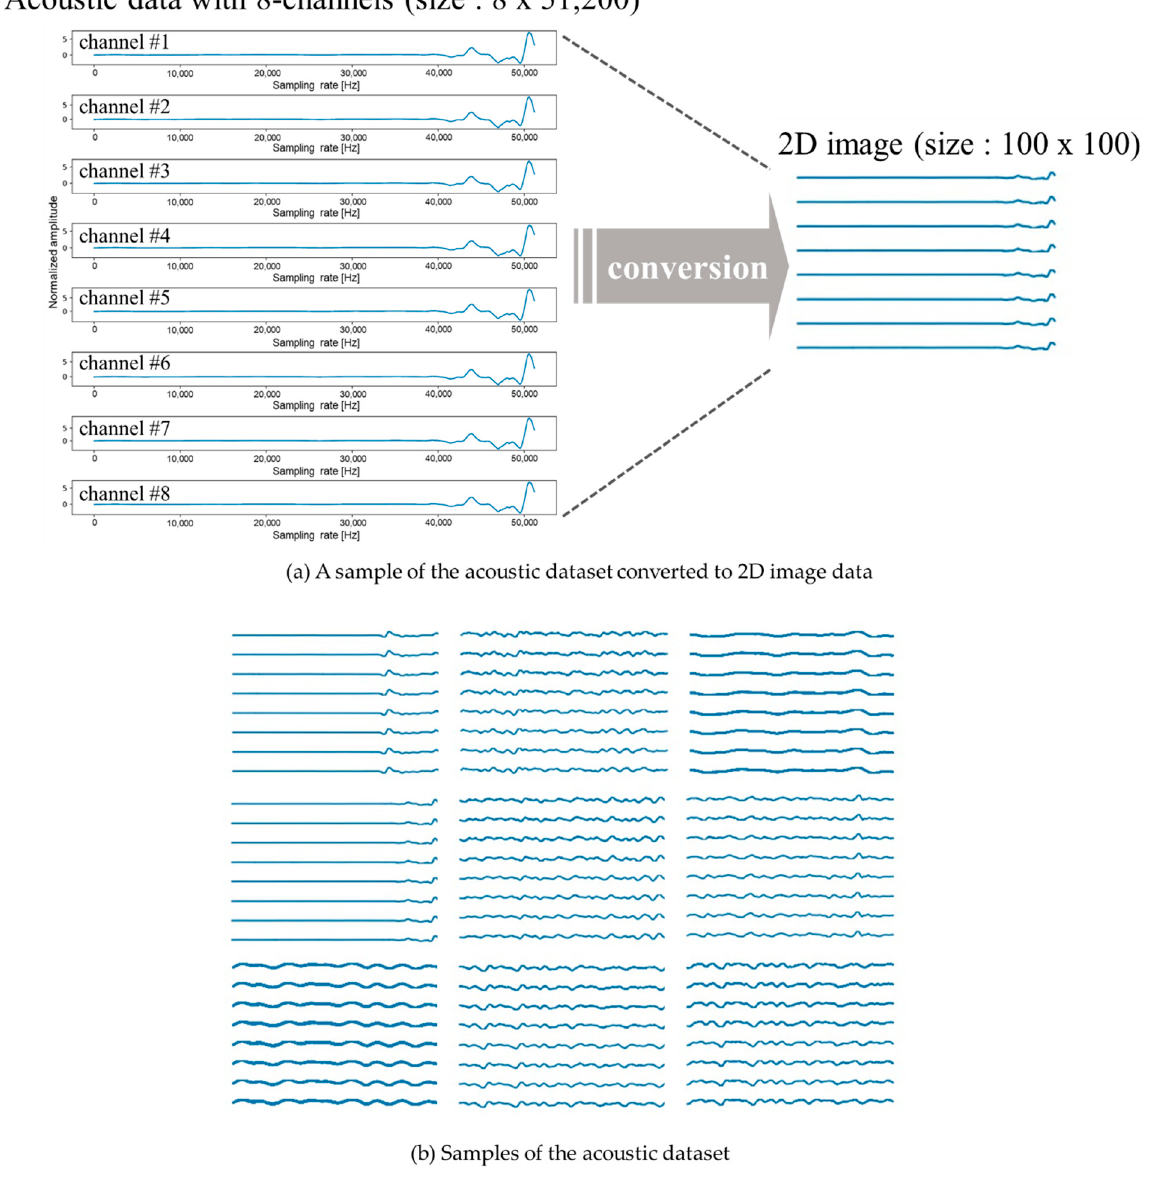
Figure 4. A sample of the acoustic dataset converted to 2D image data.